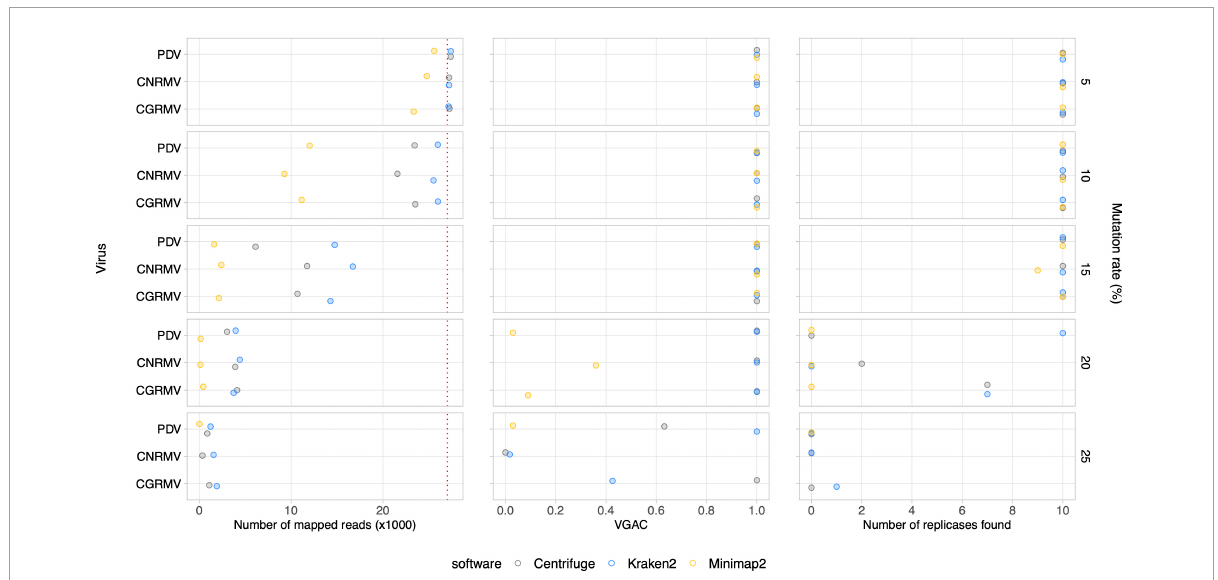
FIGURE4 Simulated mutations in synthetic HTS data. Mutated virus genomes were simulated to generate synthetic HTS dataset to evaluate read assignment tolerance to viral mutated variants. Each viral genome of the Pavium panel-I was randomly mutated at the different rates indicated (5, 10, 15, 20, and 25%) at the far right of each chart. Albeit 20 million reads were generated for each mutation rate, a 10 × subsampling of 10 million reads was performed, so dots represent a mean number of assigned reads. The distribution of viral reads in this case was homogeneous. The cases of viruses CGRMV (cherry green ring mottle virus), CNRMV (cherry necrotic rusty mottle virus) and PDV (prune dwarf virus) are shown, but a full version of this figure is depicted in Supplementary Figure 4 . Dotted red line: expected number of assigned (mapped) reads according to the distribution of reads. Average values (dots) as well as standard deviations are listed in Supplementary Table 11 .